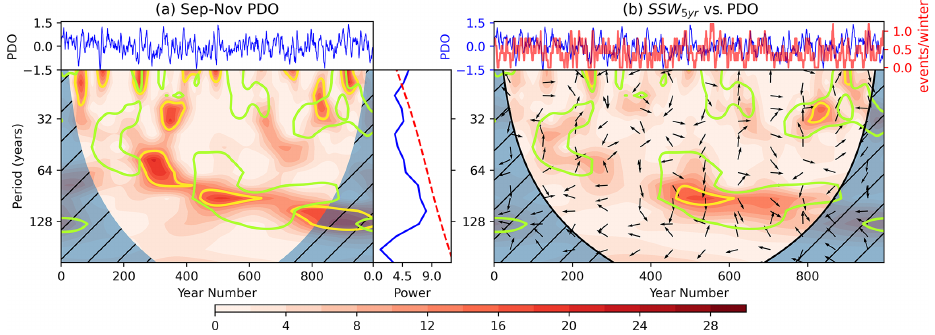
Figure A4. (a) Top: September–November PDO time series; bottom left: wavelet power spectrum (shaded contours represent wavelet power and yellow contours the 95% significance level compared to an AR1 process); bottom right: global wavelet power spectrum (blue) and 95% confidence level (dashed red). (b) Cross spectra between SSW 5 years and the PDO index. Top: PDO and SSW 5 years time series; bottom: cross-power spectrum. Shading indicates cross power, yellow contours the 95% confidence interval and arrows the relative phase angle between signals in the time series. Green contours on both spectra represent the 95% confidence intervals for the wavelet power spectrum of SSW 5 years